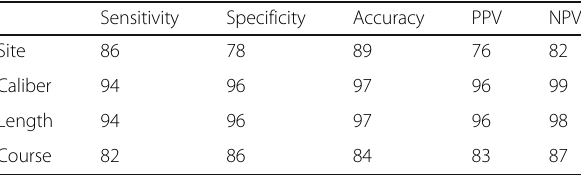
Table 2 Summarized the accuracy of CDUS in the detection of the different parameters of each perforator; site in relation to the umbilicus, caliber of perforator as it pierces the rectus abdominis, and length and course of the intramuscular segment of the perforator ( p < 0.05)